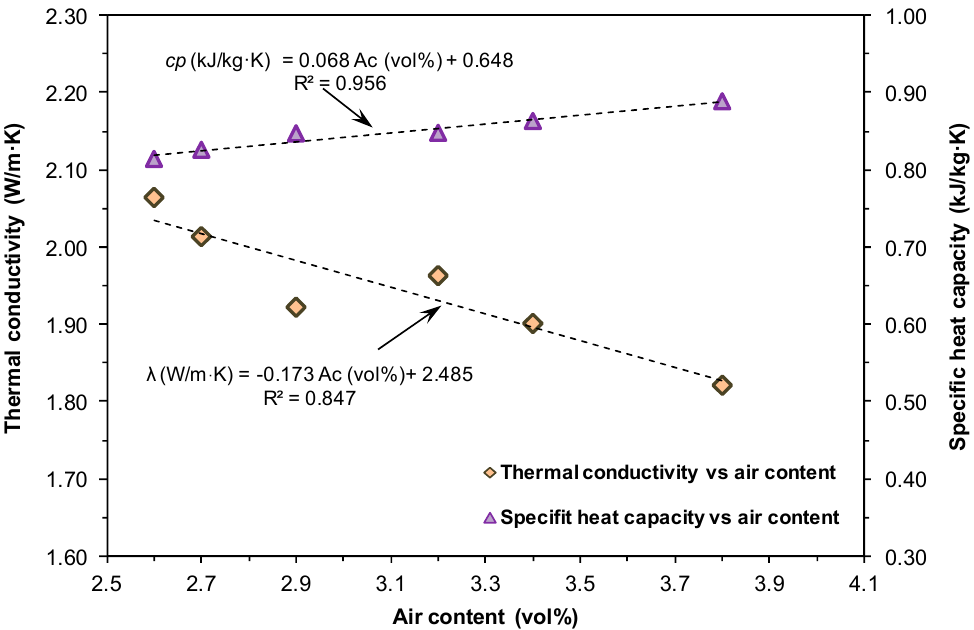
Figure 7. Air content / thermal conductivity and air content / specific heat capacity relationships for all concrete mixes.